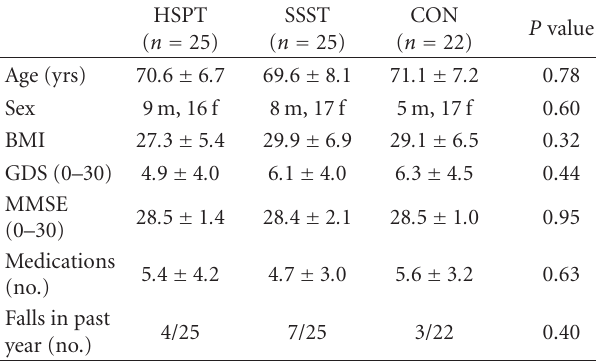
Table 1: Subject